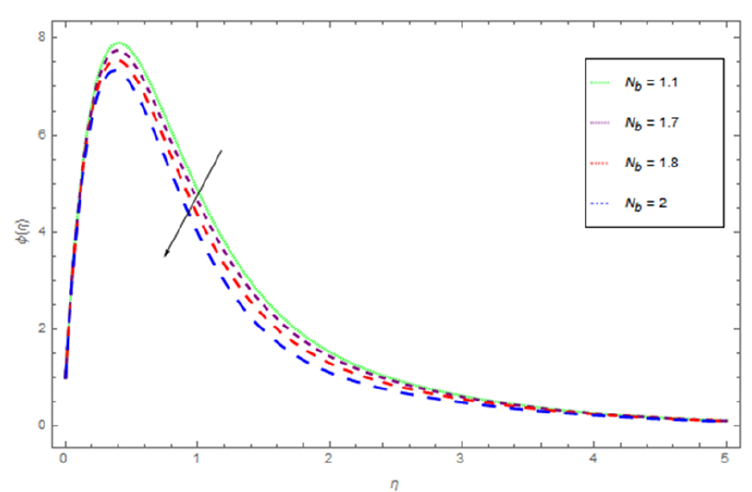
Figure 11. The influence of Sc on φ ( η ) , while N t = 0.4, γ = 0.8, N b = 0.7.